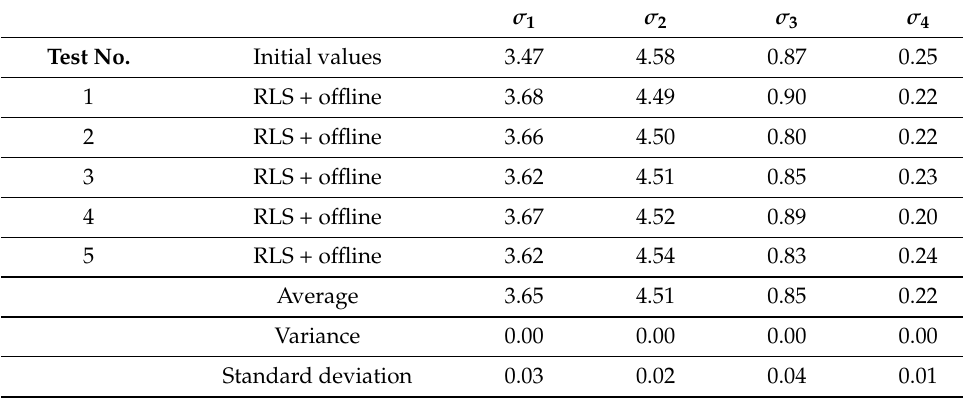
Table 3. Values of parameters identified by offline-assisted RLS